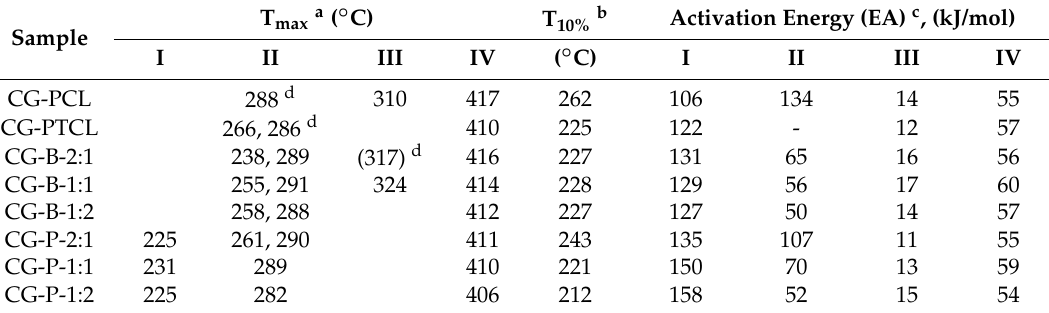
Table 5. Main TGA results of chitosan-grafted homo- and